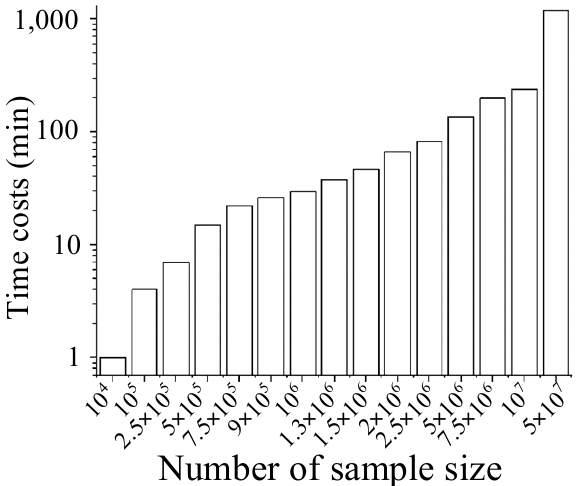
Figure 12. Time costs of cases applying MCS.